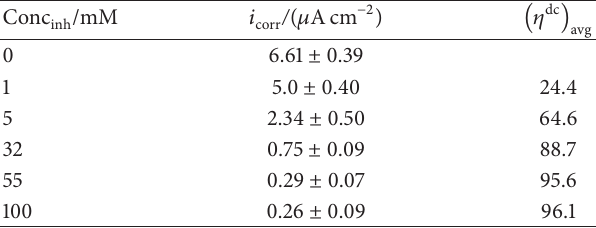
Table 4: Corrosion current density for carbon steel in 0.02 M NaCl without and with additions of sodium glutarate. The average values of inhibition efficiency at 22 ∘ C are also included.